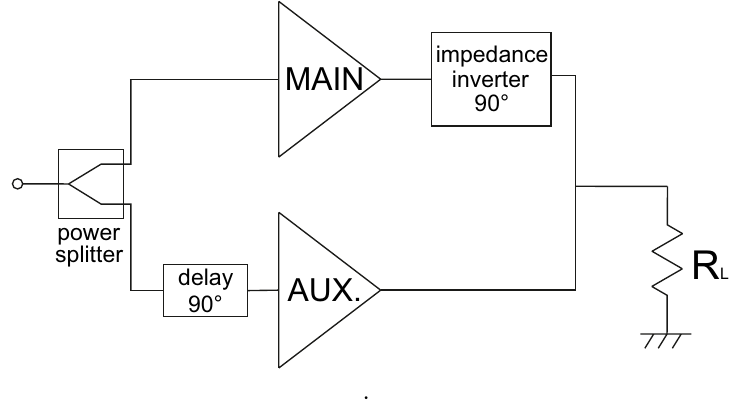
Figure 4. Doherty power amplifier